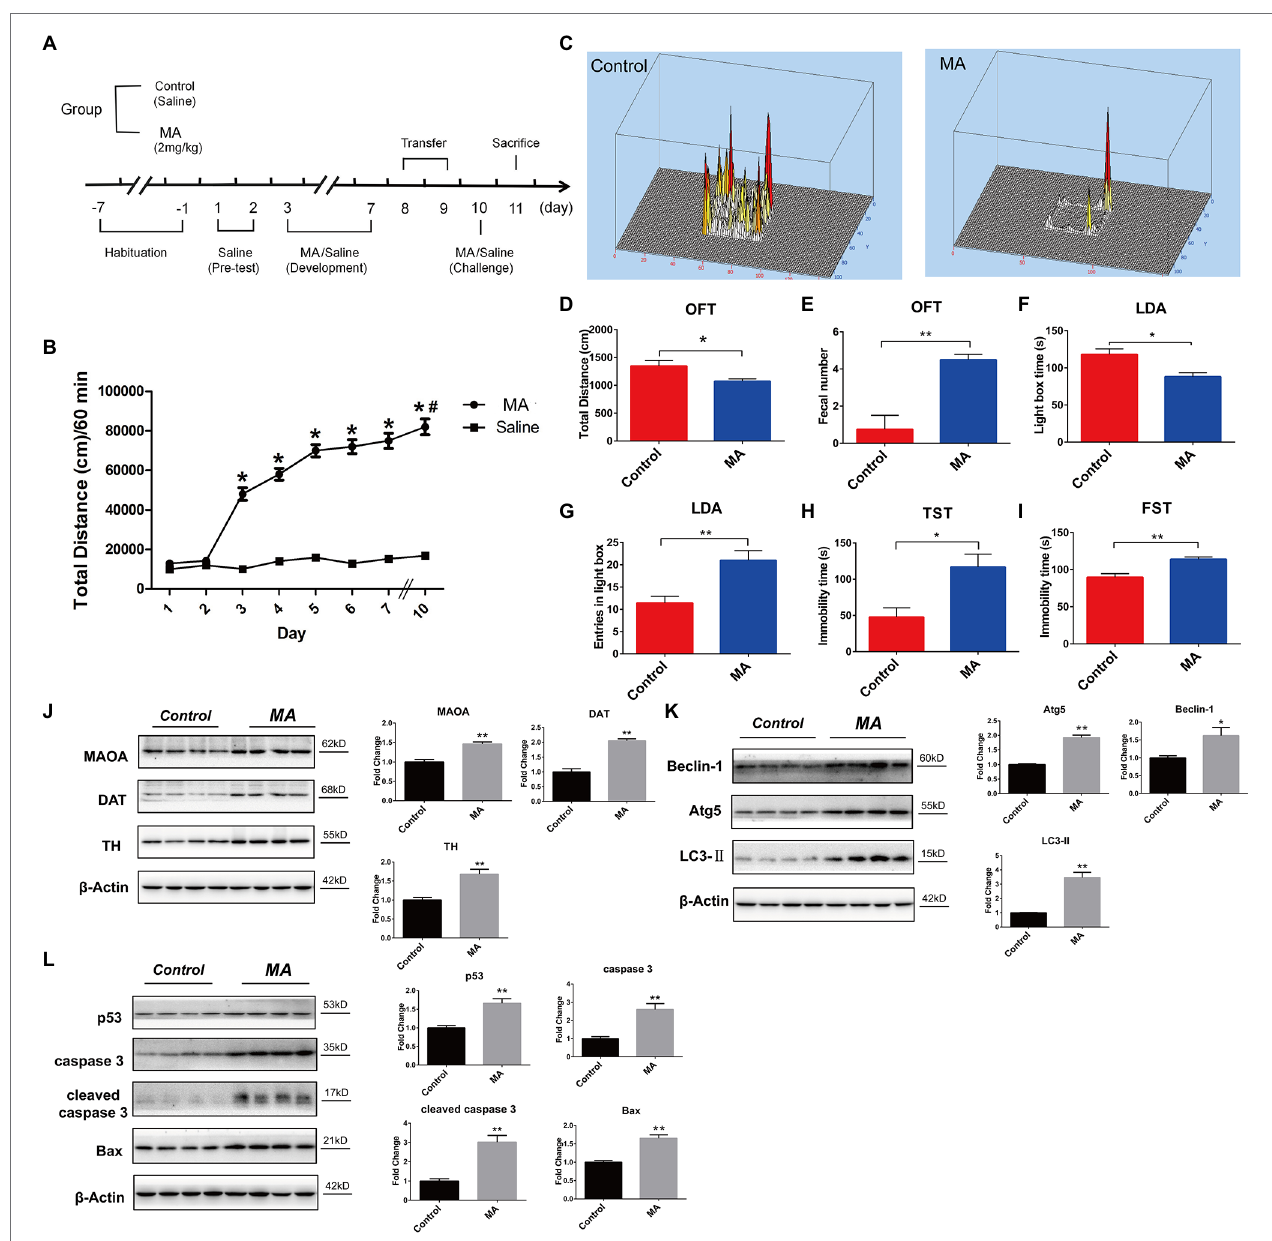
FIGURE 1 | Methamphetamine (MA)-induced abnormal behaviors and striatal neurotoxicity in mice. (A) MA treatment schedule. (B) MA obviously elevated the locomotor activities, relative to the control group, * p < 0.05; in MA group, 2 days’ interval further enhanced the locomotor activities in comparison with day 3, # p <